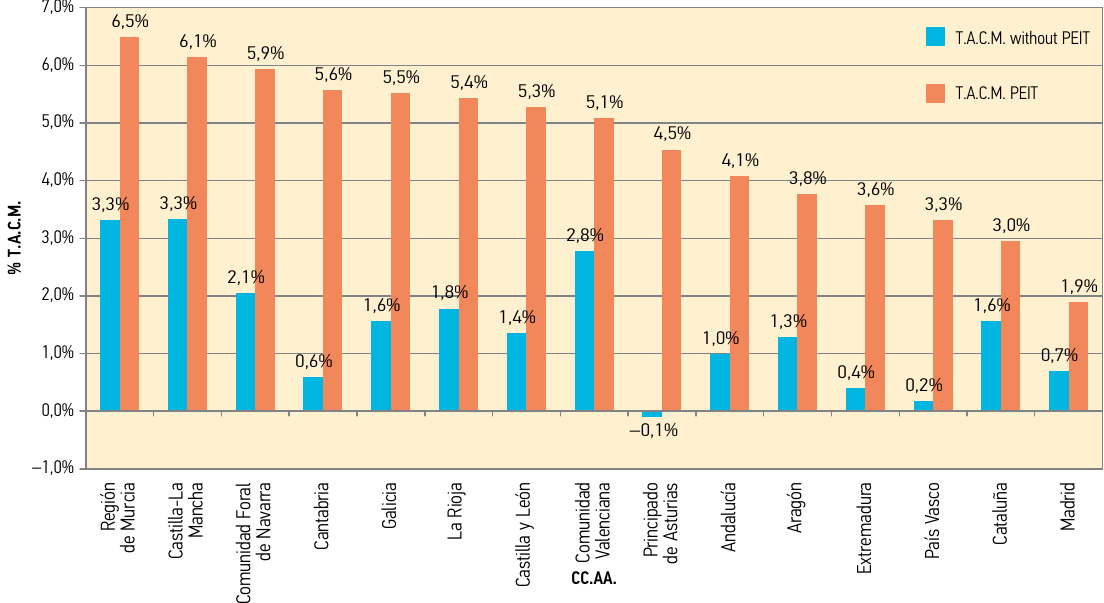
Fig. 6. Comparison of average annual accumulative rates of employee compensation at constant